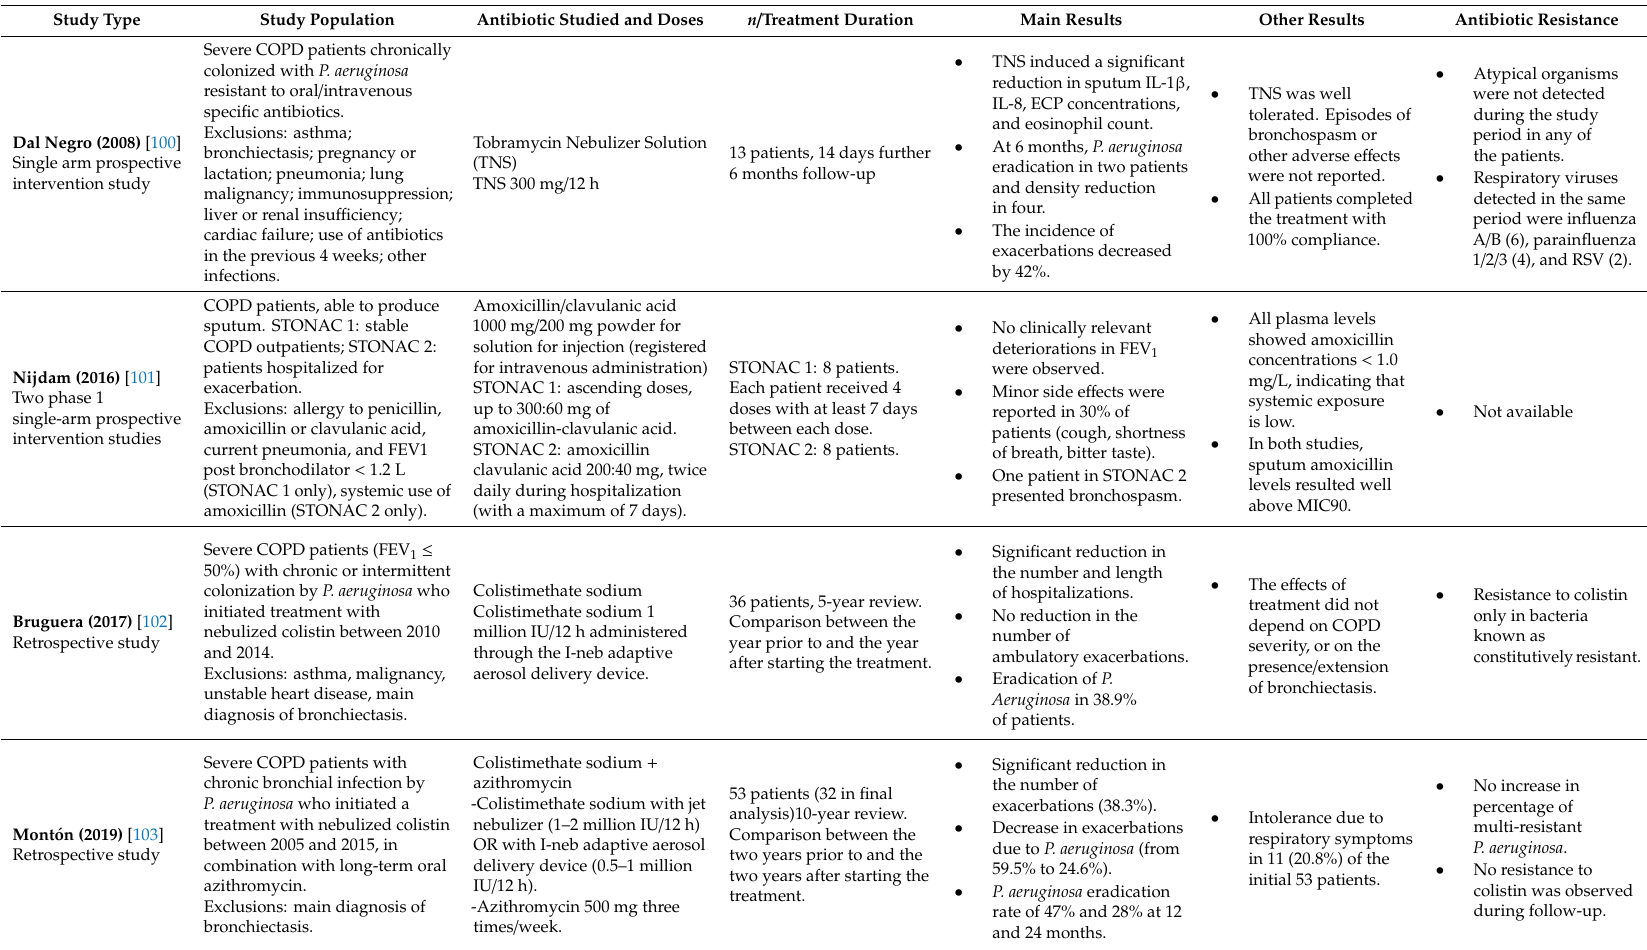
Table 5. Main publications on the use of inhaled antibiotics in patients with stable